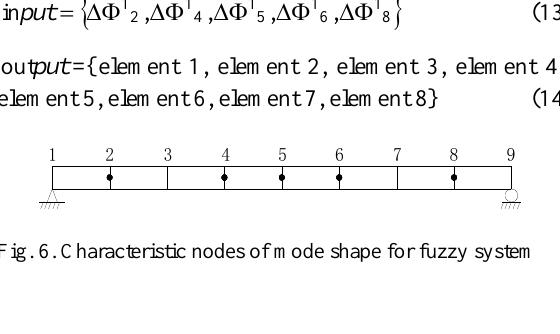
Fig. 7. Schematic diagram of membership function of